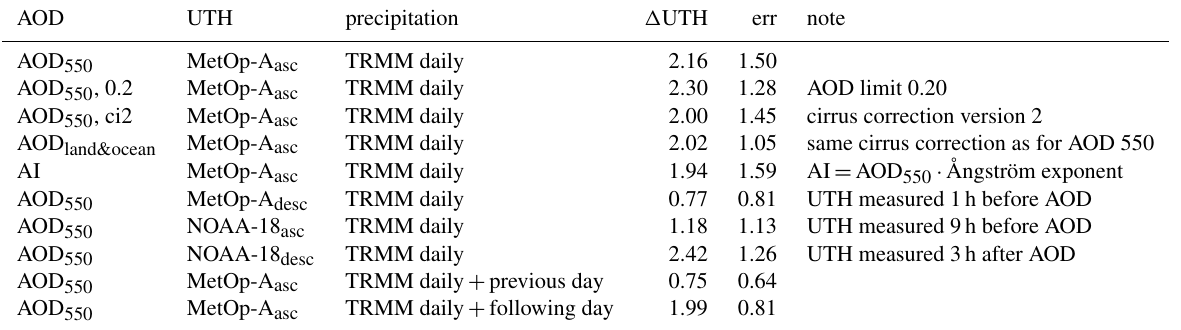
Table 2. Results from the sensitivity tests. (cid:49) UTH is calculated for different MODIS aerosol products, for UTH from different overpassing times and satellites, and for different precipitation measurement time spans. Small (cid:49) UTH values are obtained when there is precipitation on the previous day (i.e. wet scavenging) or when UTH is measured before AOD